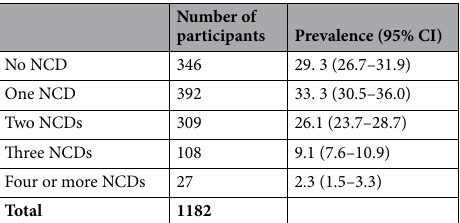
Table 2. Prevalence of number of non-communicable diseases with 95% confidence intervals.